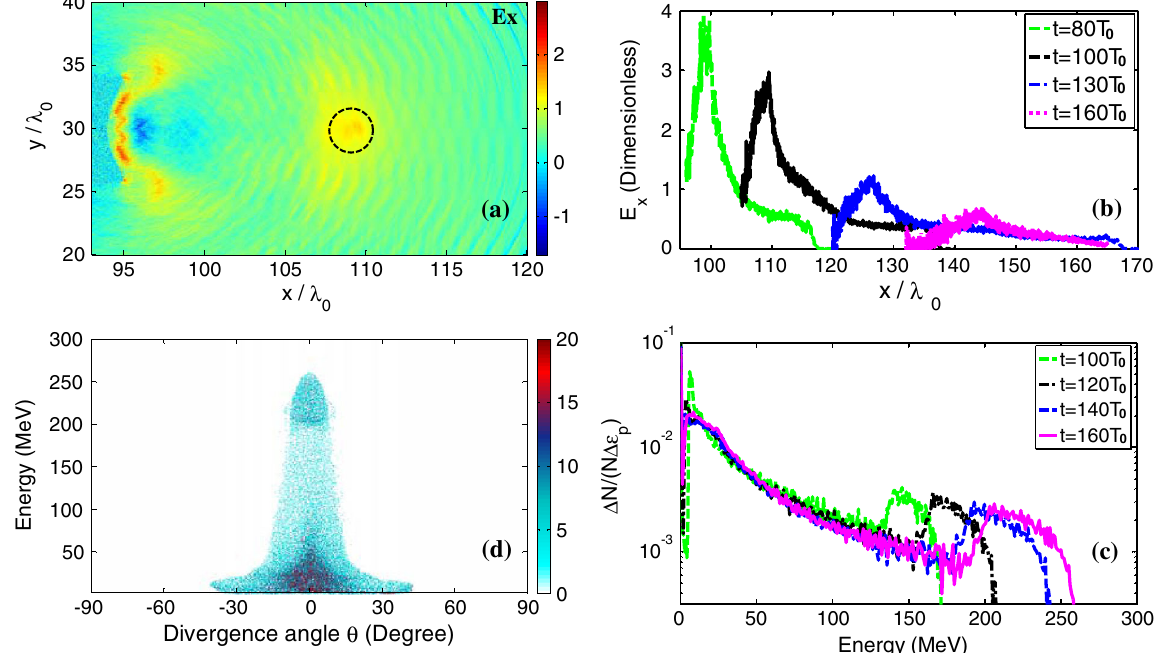
FIG. 3. 2D PIC simulation results of (a) spatial distribution of the axial electrostatic field E x (normalized by m e ! 0 c=e ) in the x - y plane at t ¼ 100 T 0 . An enhancement of the field at x ¼ 108 (cid:2) 0 can clearly be observed. (b) Evolution of the peak of E x on the axis near the interface between the front of the O-protons and the I-protons. Except for that for t ¼ 80 T 0 , the E x values have been multiplied by a factor of 2 for clarity. (c) Evolution of the quasimonoenergetic I-proton peak. (d) Divergence angle and kinetic energy distribution of the I-protons at t ¼ 160 T 0 ; The laser parameters are the same as in Fig.